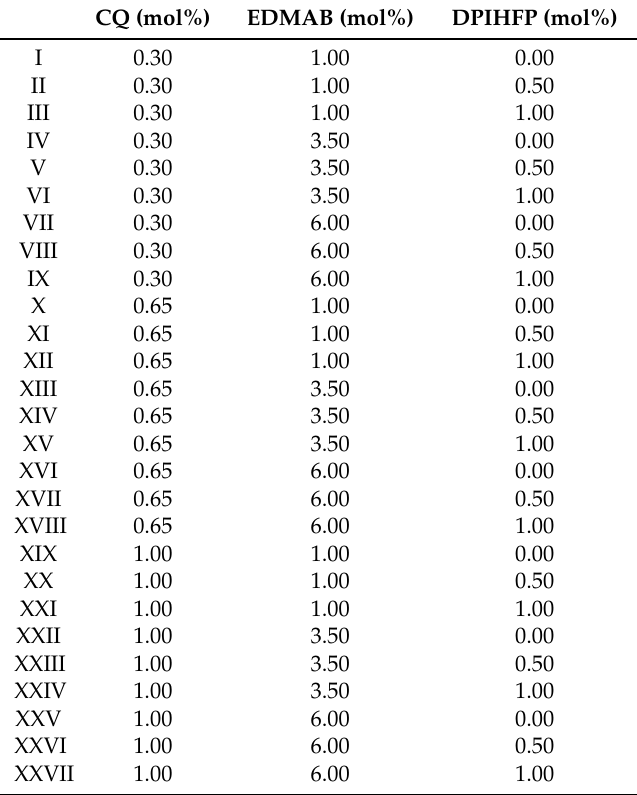
Table 2. Photoinitiator combinations for investigating an influential index.